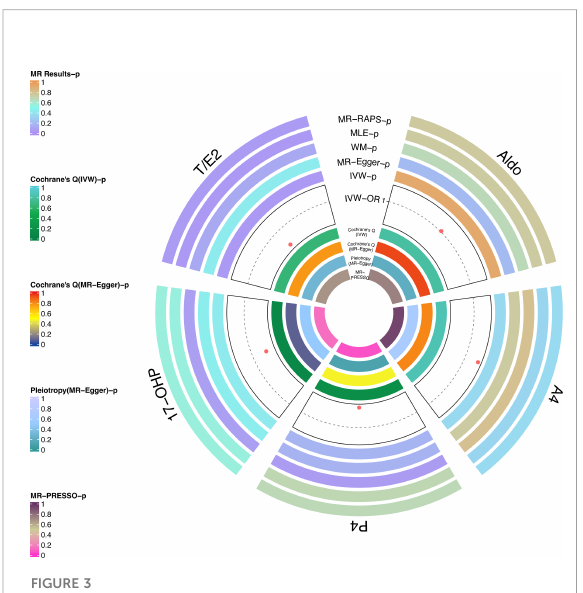
FIGURE 3 Causal analysis of steroid hormone and glaucoma based on MR analyses and sensitivity analyses in the replicated stage.